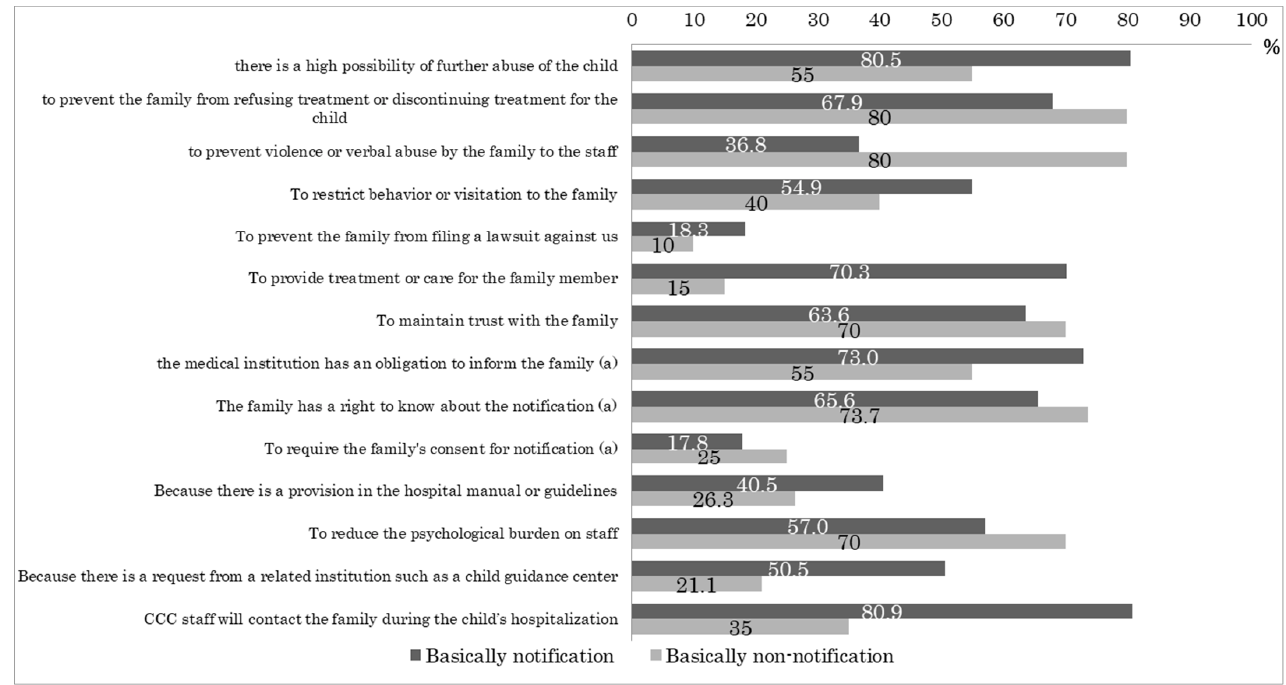
Figure 1. Reasons for the response policy for the notification and non-notification groups. Note: The number for each item = (number of facilities that chose “true” or “somewhat true”)/(number of facilities that answered the entire item). (a) In the non-notification group, the following items are inverted: “the medical institution is not obliged to inform the family,” “the family has no right to know about the notification,” and “the family’s consent is not necessary for the notification.” For facilities that did not choose “true” or “somewhat true” for any of the above items, “true” was taken as the response and the responses were included in the percentages calculated in the table in this figure. Since the items are not the same as those of the notification group, we need to be careful in interpreting the results.